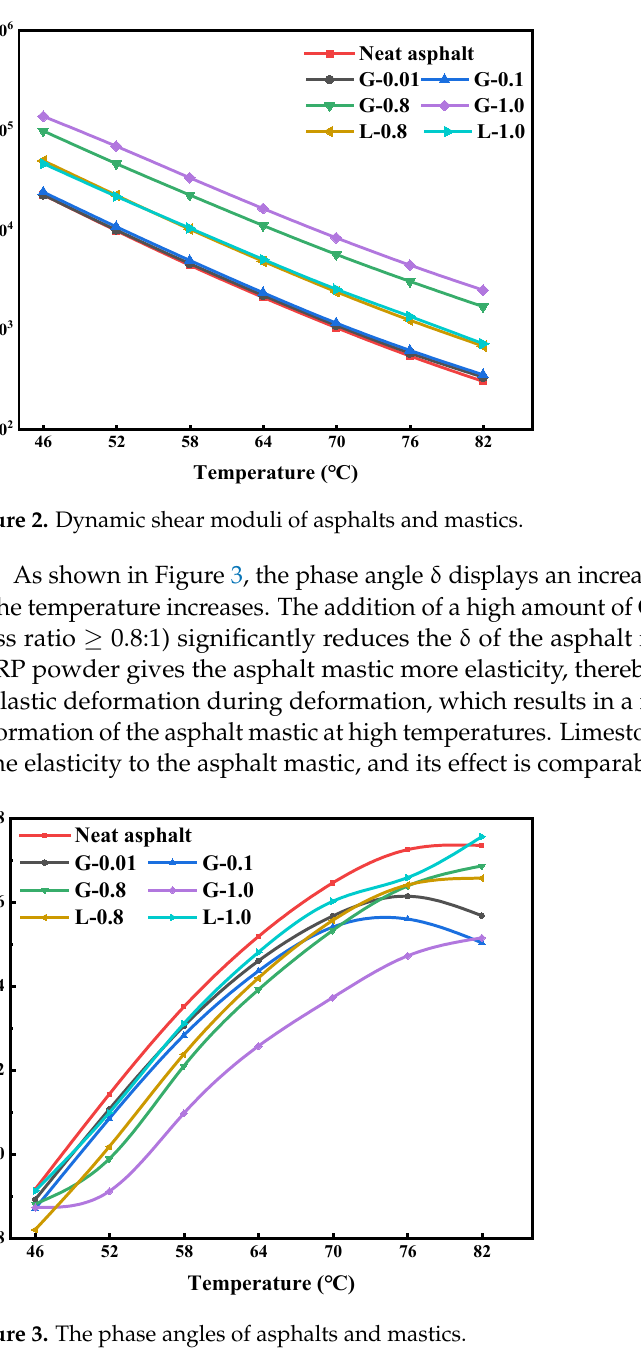
L-1.0 Figure 4. Complex viscosity of asphalts and mastics.